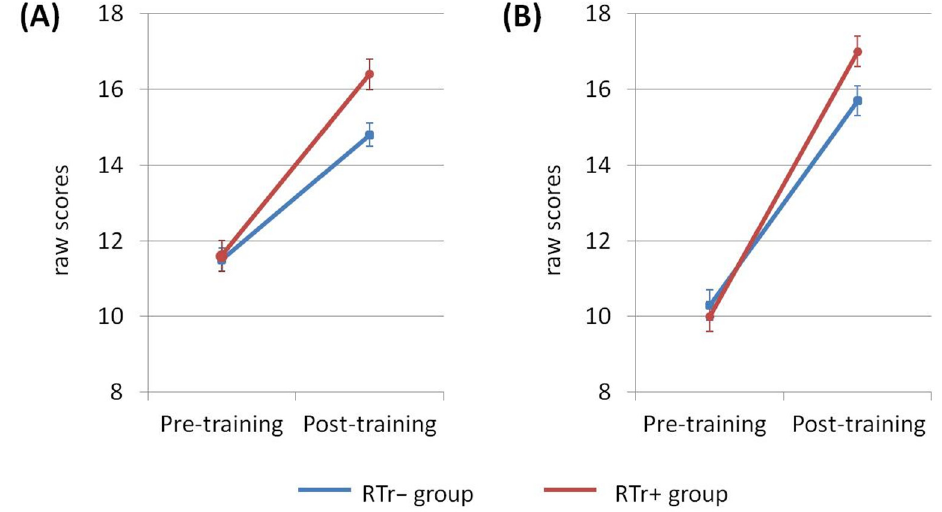
Figure 3. Descriptive graphical representation of the pre-training vs. post-training comparison for ( A ) the Bayley Receptive Communication and ( B ) Expressive Communication subtests. Error bars indicate SEM.